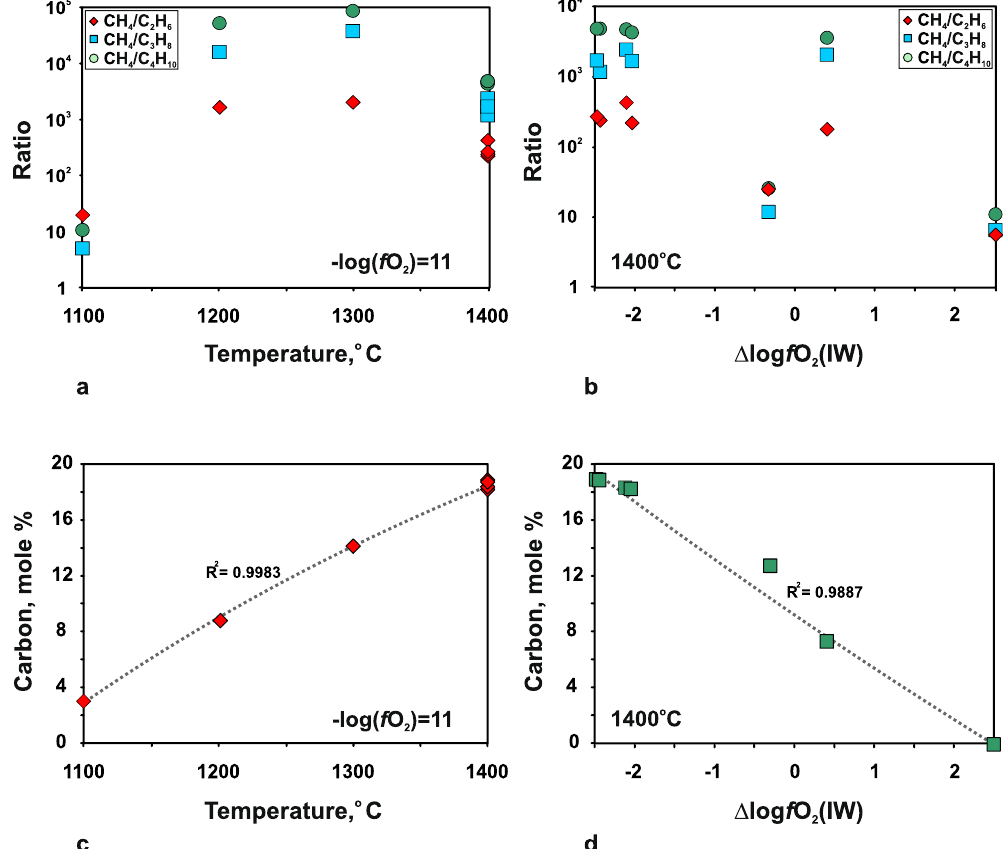
Figure 7. Composition of quenched fluids converted using GC-MS calibration with respect to main species: CH 4 , C 2 H 6 , C 3 H 8 , C 4 H 10 and H 2 O. a: mole ratios CH 4 /C 2 H 6 , CH 4 /C 3 H 8 and CH 4 /C 4 H 10 in strongly reduced fluids at 6.3 GPa, 1100–1400 °C and constant f O 2 ; b: same at 6.3 GPa, 1400 °C in a range of f O 2 ; c: amount of carbon in fluids as a function of temperature; d: amount of carbon in fluids as a function of f O 2